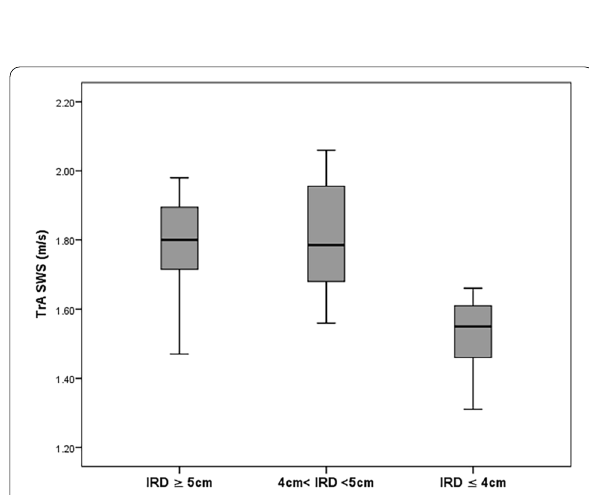
Fig. 7 Boxplot of TrA shear wave speed distribution in 36 DRA patients ( IRD inter-rectus distance, TrA transversus abdominis, SWS shear wave